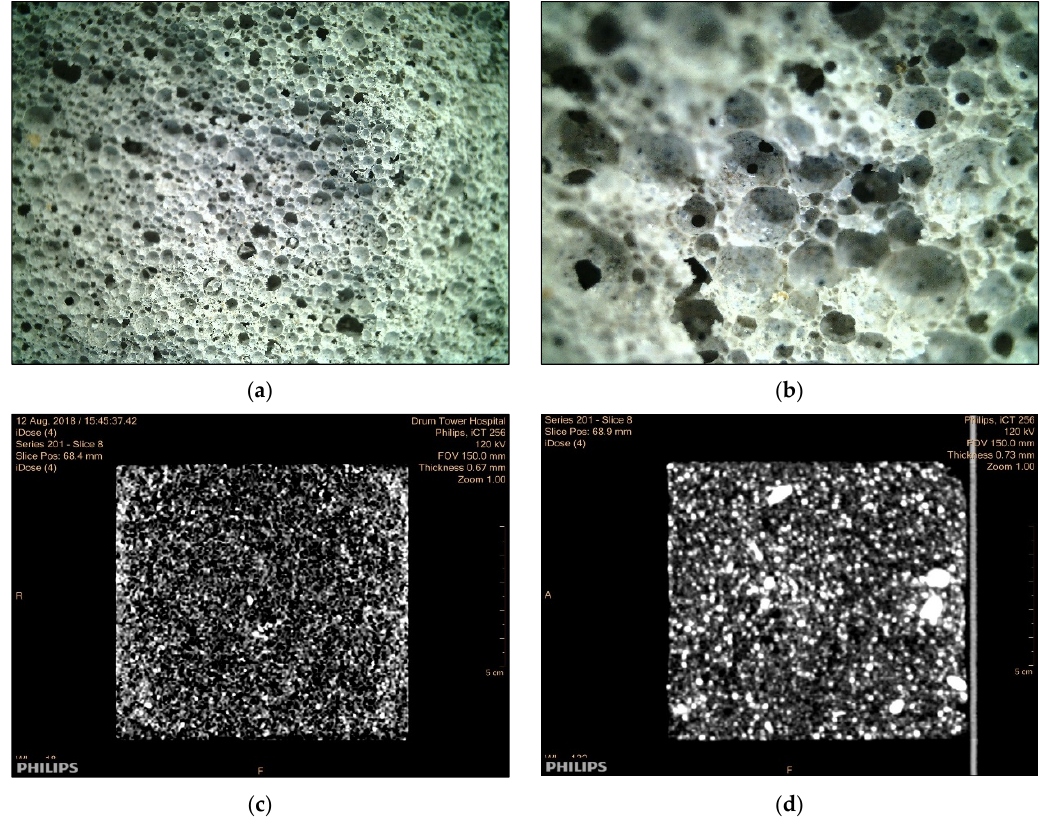
Figure 7. Pore morphology of the foam backfill material with different W/B ratios. ( a ) 0.40 W/B ratio, ( b ) 0.50 W/B ratio, ( c ) 0.40 W/B ratio through the CT scan, ( d ) 0.50 W/B ratio through the CT scan.